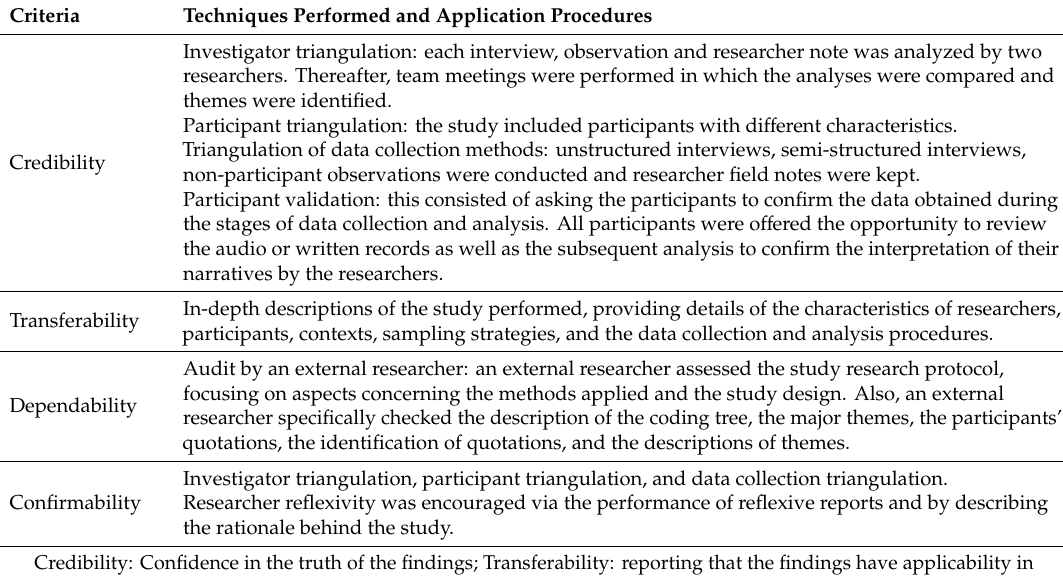
Table 4. Trustworthiness